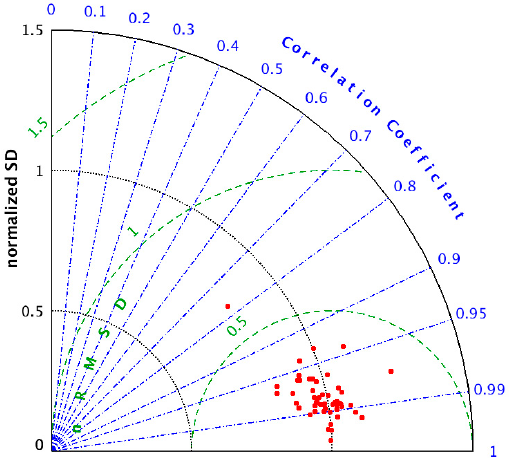
Figure 15. The Taylor Diagram of the sea-surface temperature. Shown on the plot are the model-data